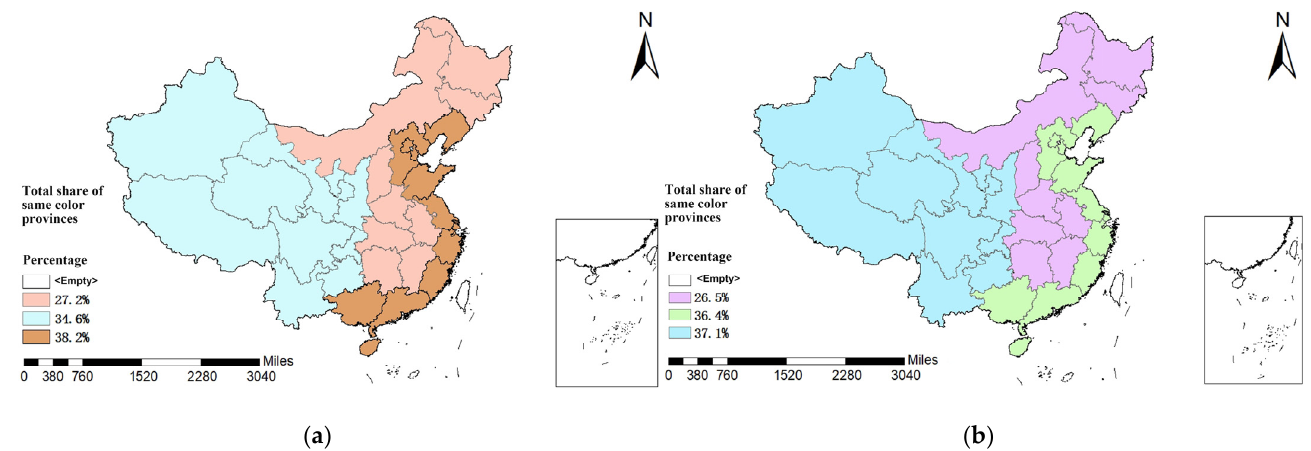
Figure 1. ( a ) Distribution of the three major regions in China and the percentage of children and adolescents who participated in soccer. ( b ) Distribution of the three major regions in China and the percentage of children and adolescents who liked or were proficient in soccer.